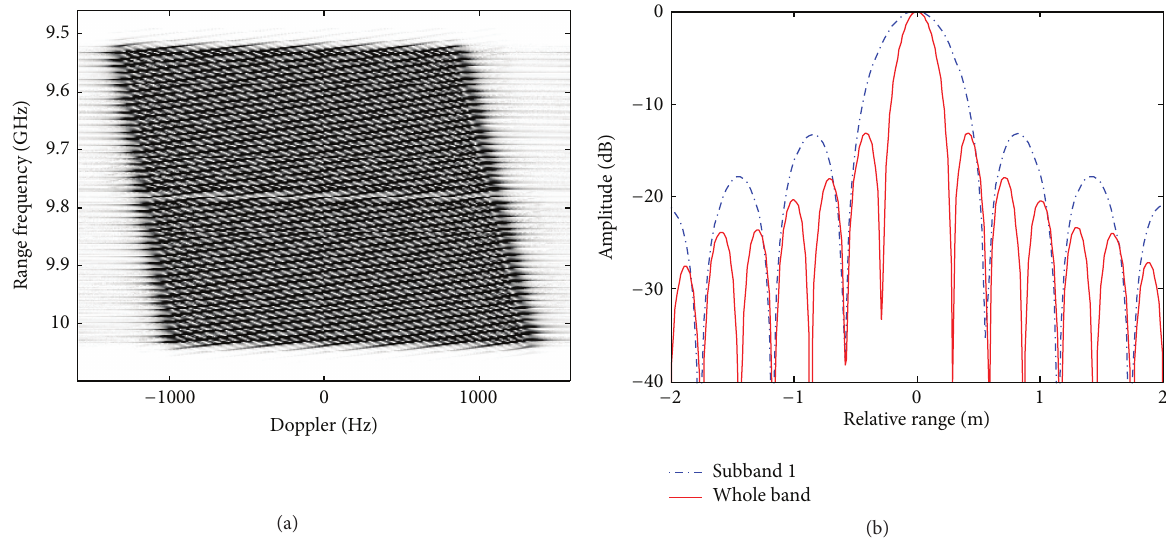
Figure 6: (a) 2D spectrum of the whole bandwidth signal. (b) Range images of a point target before and after bandwidth synthesis.